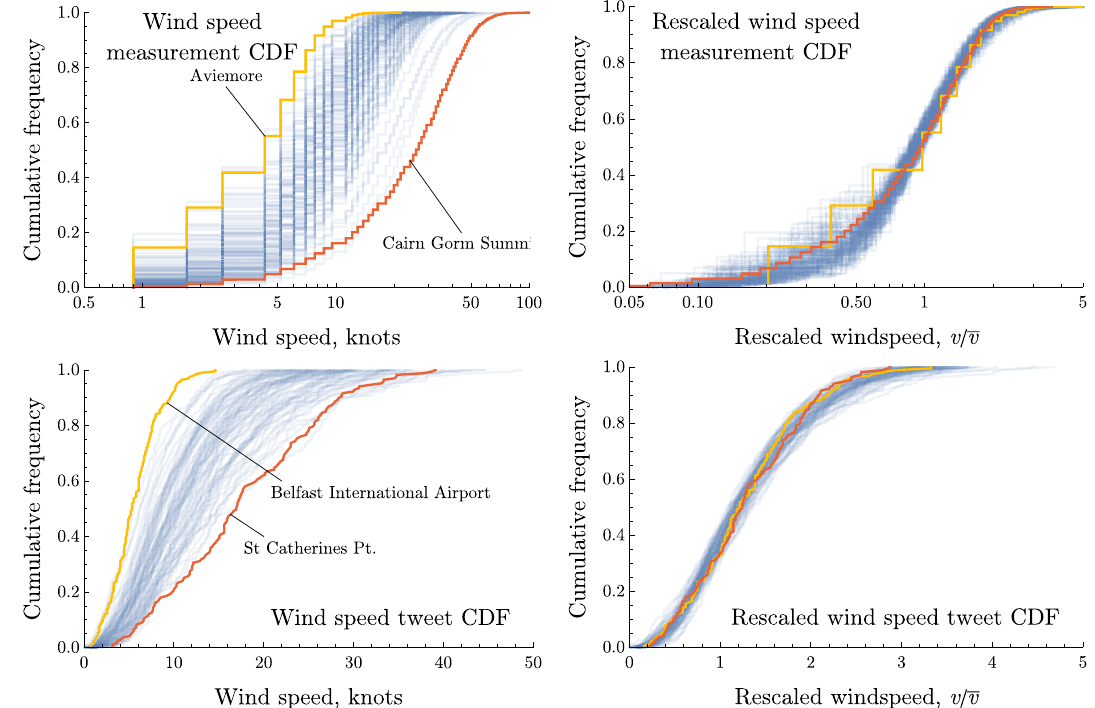
Figure 5. Local re-scaling of wind speeds. Top panels : Cumulative distributions of wind speeds at each weather station, with the stations having highest and lowest mean wind speeds highlighted. In the left panel, the data is unaltered. In the right panel, each distribution has been re-scaled by dividing each wind speed by the mean value for the distribution. Bottom panels : Cumulative distributions of wind speeds associated with individual tweets. In the left panel, wind speeds are unaltered. In the right panel, each distribution is re-scaled by dividing each wind speed by the mean value for the